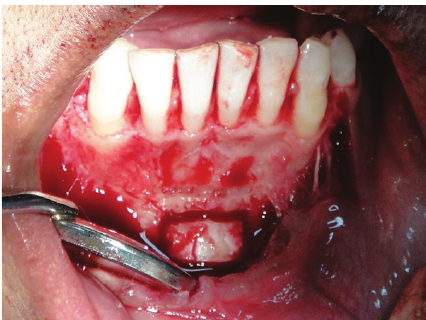
Figure 7: Outline of the block graft harvested from mandibular symphysis.